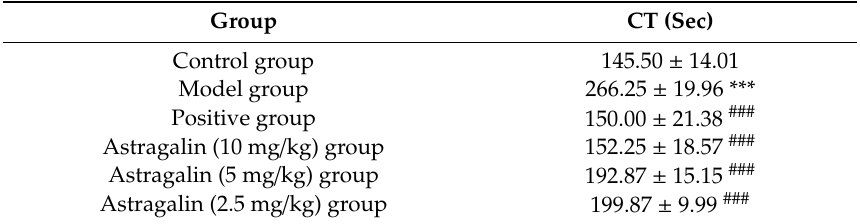
Table 3. Effects of astragalin on CT (X ± SD, n = 8). Table 3. E ff ects of astragalin on CT (X ± SD, n = 8).